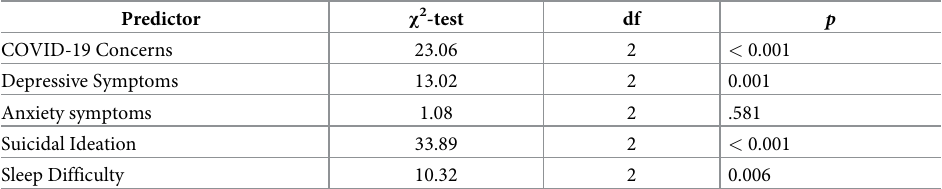
Table 4. Predictors’ unique contributions in the multinomial logistic regression (n = 516). Predictor